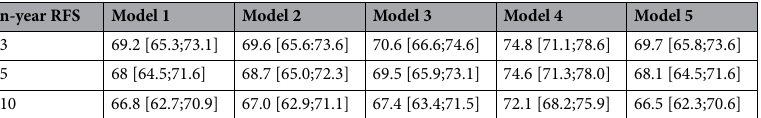
Table 4. The AUC of model validation using independent data sets. Models are under the control of node status.